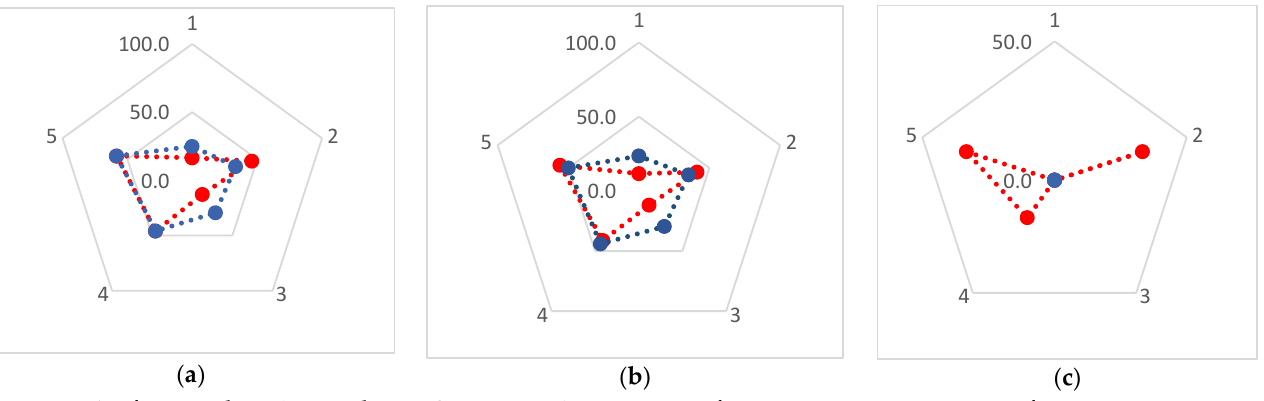
Figure 8. Percentage of points for Landscape/English-style park: ( a ) level 1; ( b ) level 2. Percentage of points for Romantic/Sentimental-style park: ( c ) level 1; ( d ) level 2.